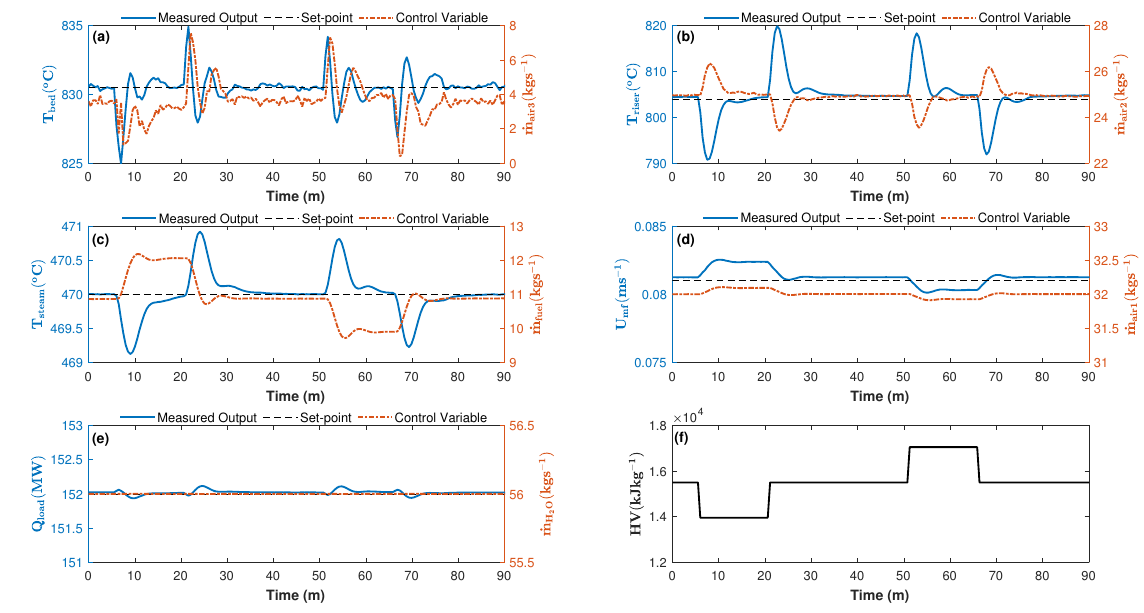
Figure 7. Measured output response to a step-change in the fuel’s heating value ( f ). Simulated using PI (proportional-integral control) controllers with set-points on the measured outputs in conjunction with the following control variable relationships: bed temperature—tertiary air flow rate ( a ); riser temperature—secondary air flow rate ( b ); steam temperature—fuel mass flow rate ( c );